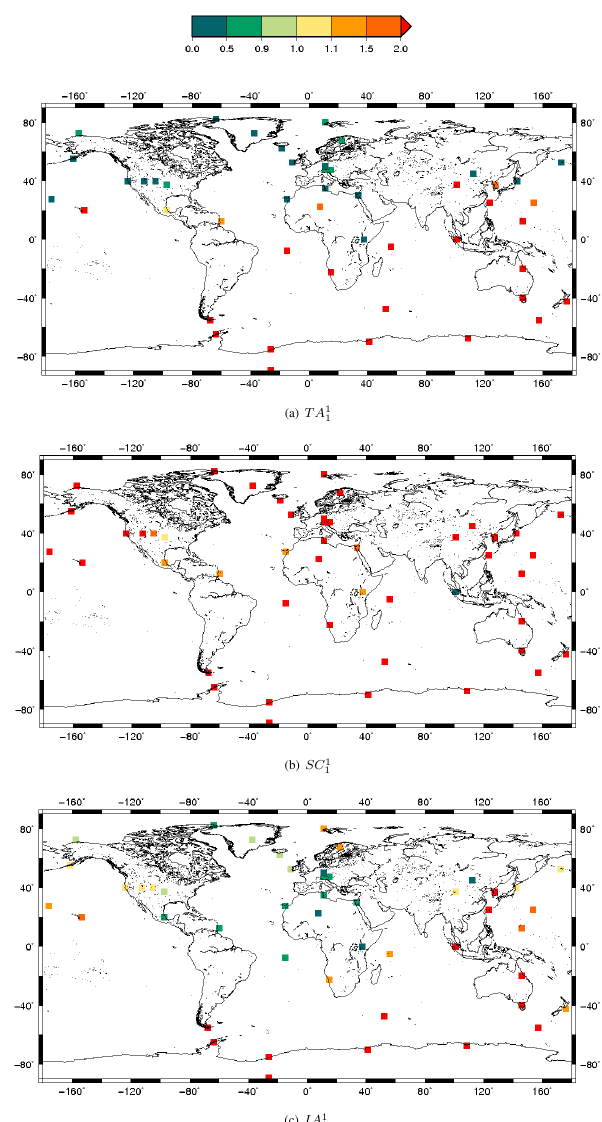
Fig. 7. Fit at surface sites (unitless) represented as the ratio of the posterior to the prior values of bias (in absolute values) between simulatedandobservedmethaneconcentrations.